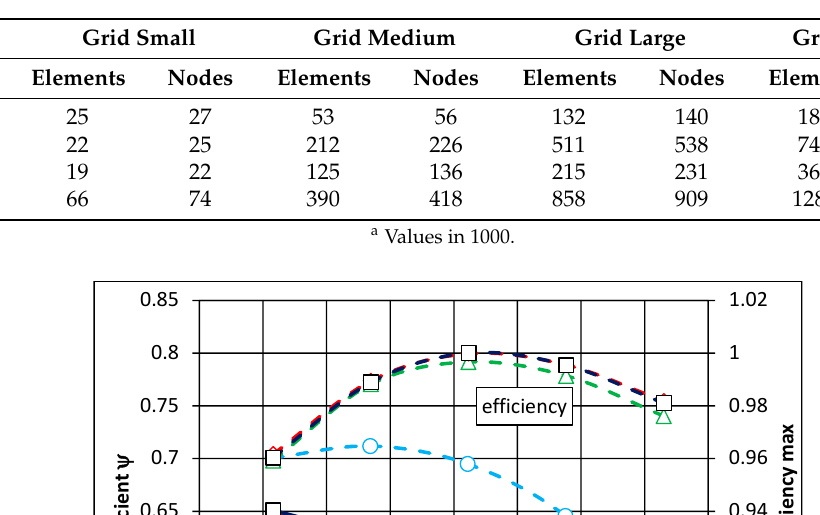
Table 2. Mesh statistics for grid dependency study a .